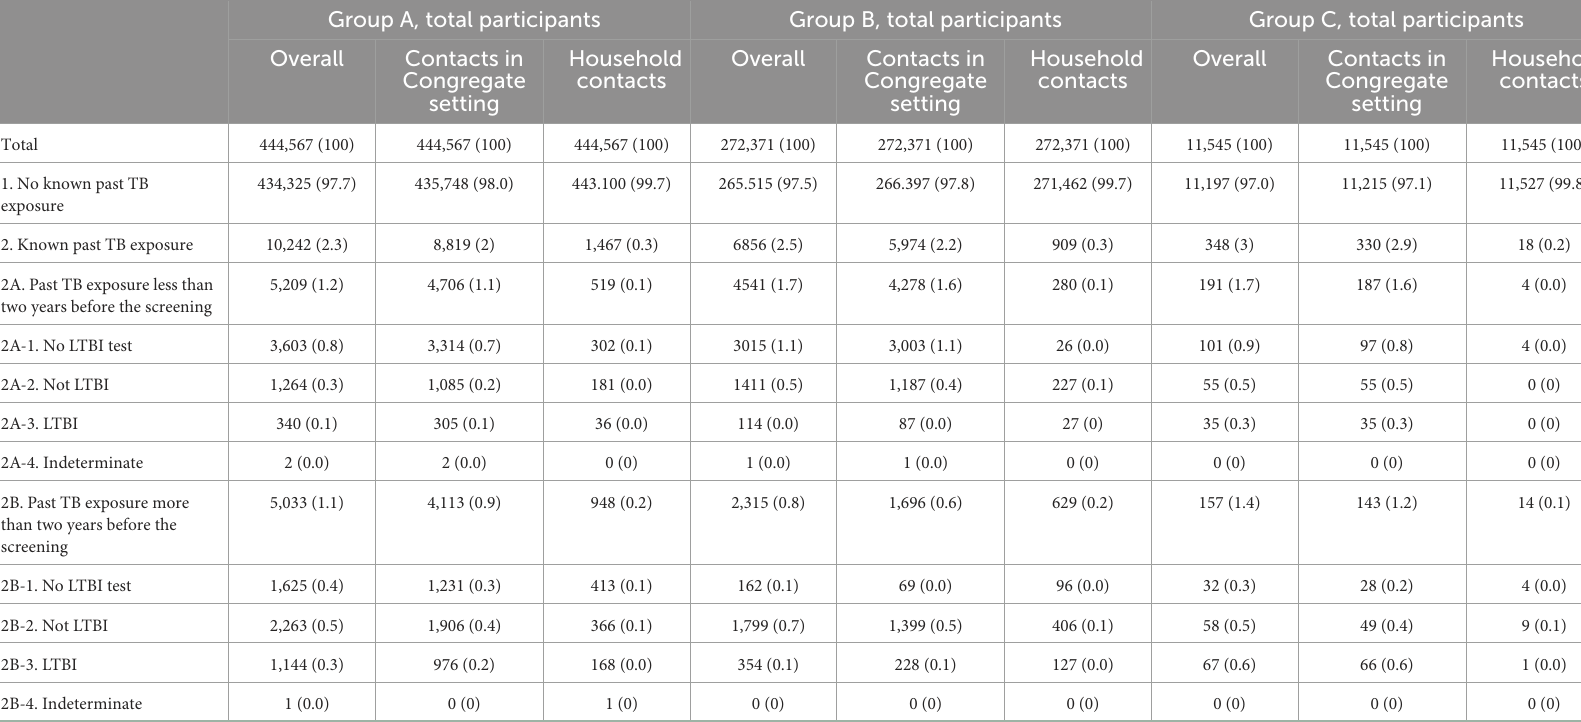
Datawereexpressedasnumberandcolumnarpercentage.LTBI,latenttuberculosisinfection;TB,tuberculosis.GroupA:workersofpostpartumcarecenters,socialwelfarefacilitiesandeducationalinstitutions,GroupB:firstyearstudentsinhighschool